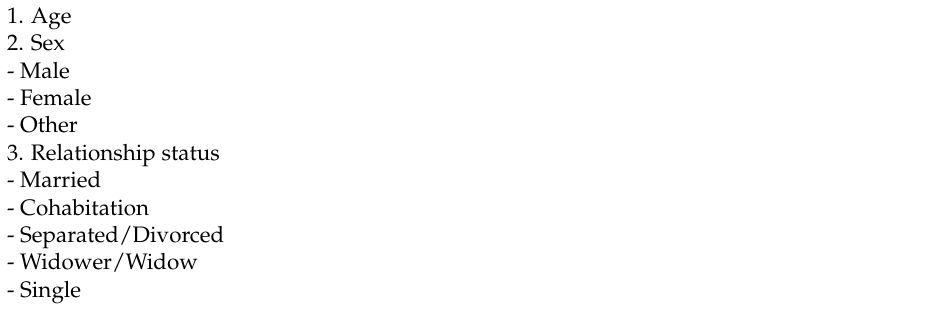
Table A1. Self-administered